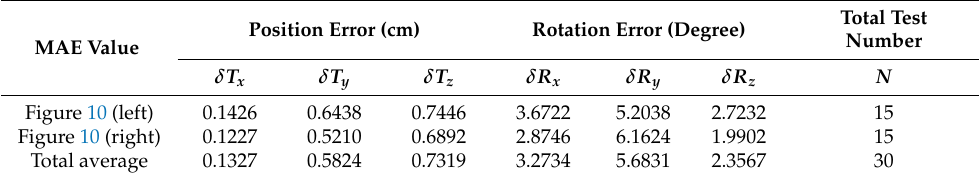
Table 4. MAE measures of the 3D keypoint detection system results shown in Figure